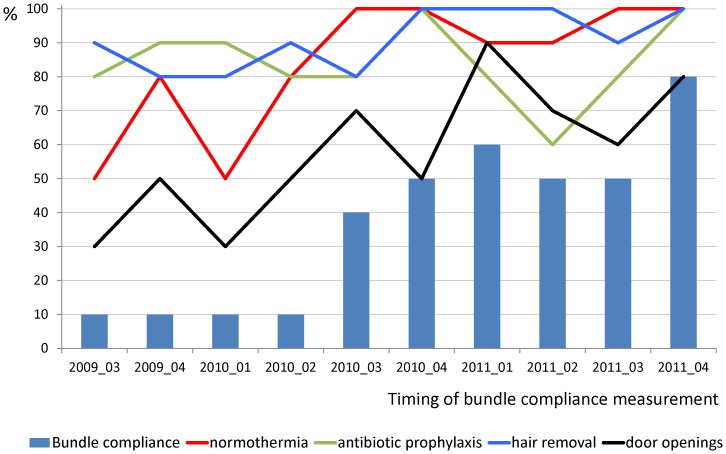
Compliance with the bundle and its individual components in repeated measurements from June 2009 through October 2011.